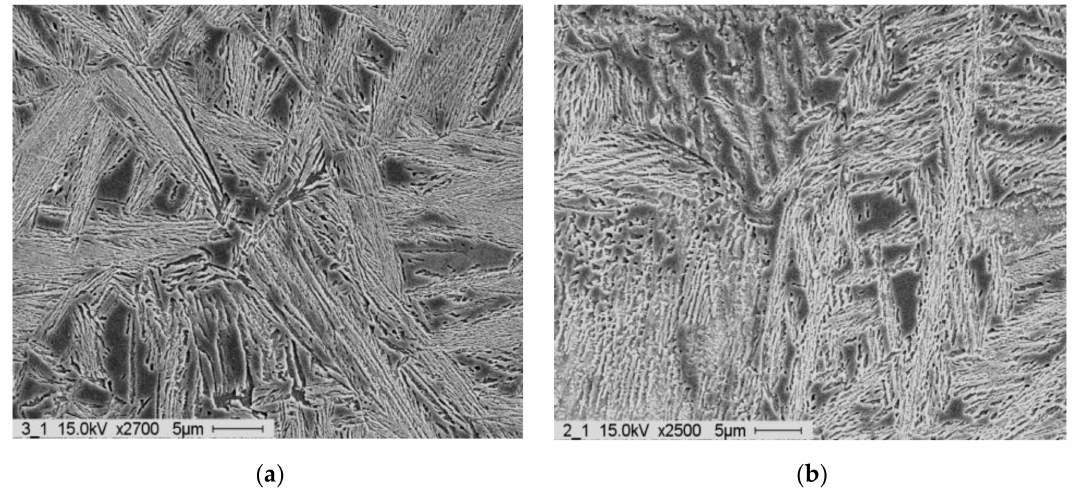
Figure 28. SEM micrographs of ( a ) medium feathery ausferrite and ( b ) highly feathery